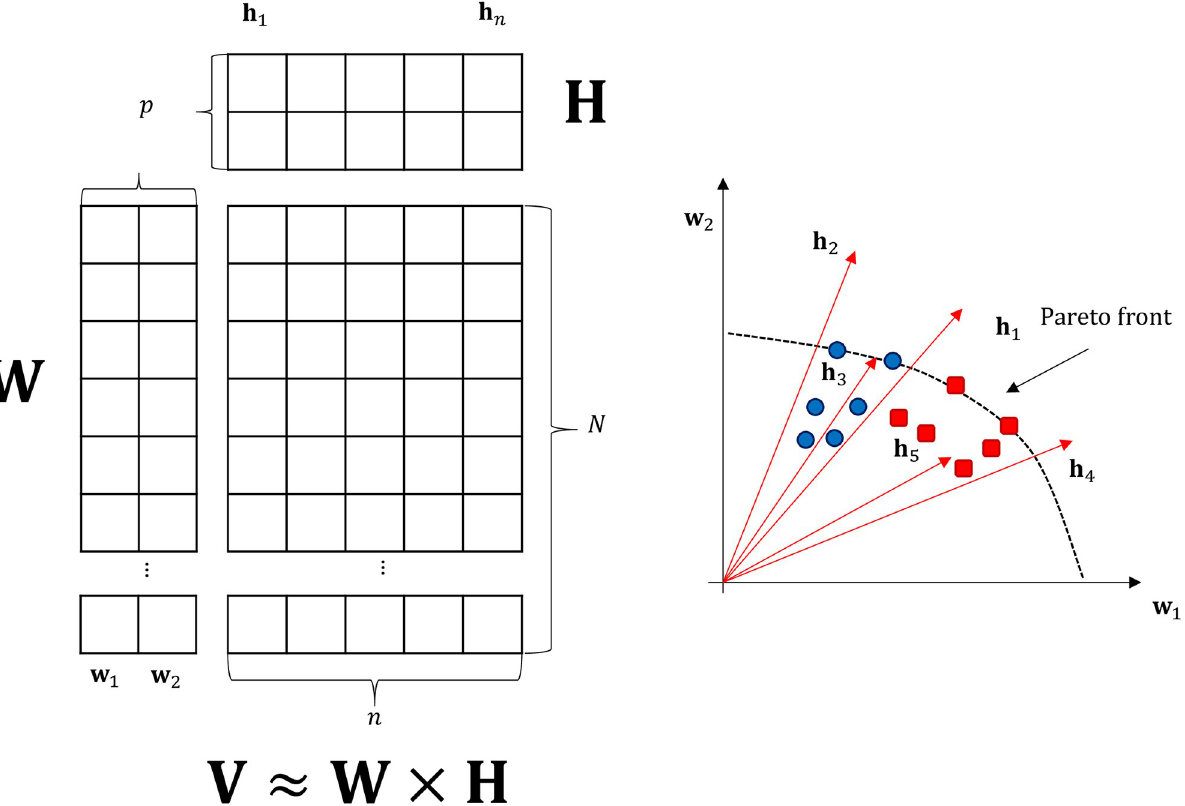
Fig 5. Illustration of non-negative matrix factorization in two dimensions. When the linear combination of W N × p and H p × n is considered, an approximation ( ^ X ) of X is obtained. Moreover, the technique has inherent clustering properties, with which the objectives are automatically N × n clustered in W as are the solutions and the Pareto Front. h k denotes the coefficients of objectives in relation to the components, which define the relationship between the